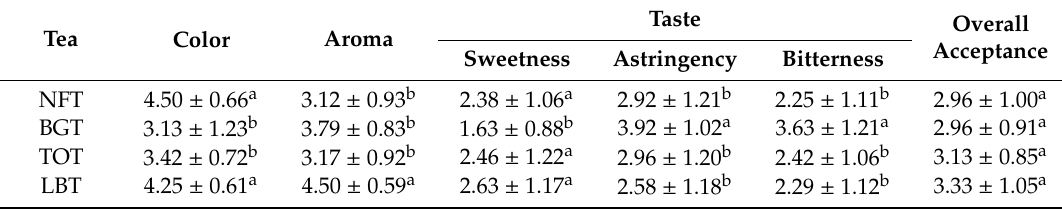
Table 7. Sensory evaluation of di ff erent tea